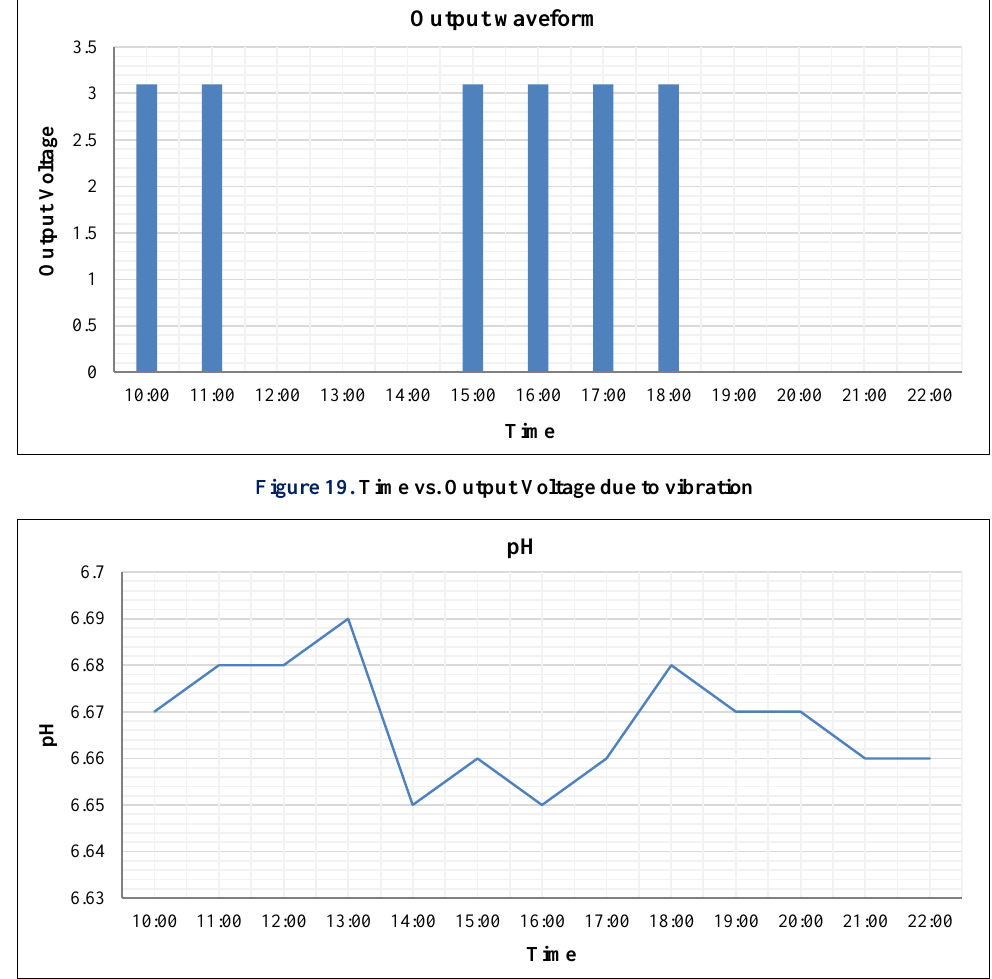
Figure 20. Time vs. pH